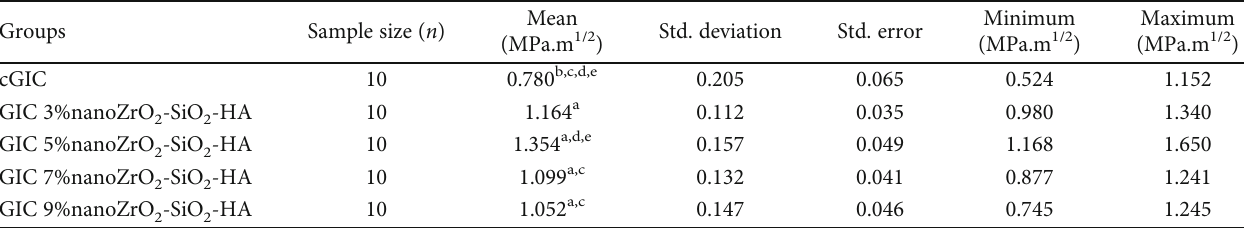
-SiO -HA using one-way ANOVA. 2 2